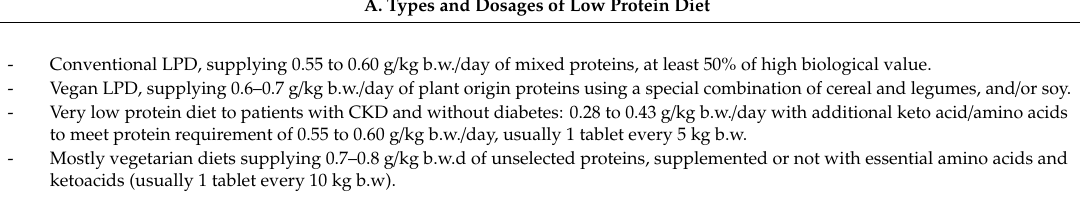
Table 3. Low protein diets as a